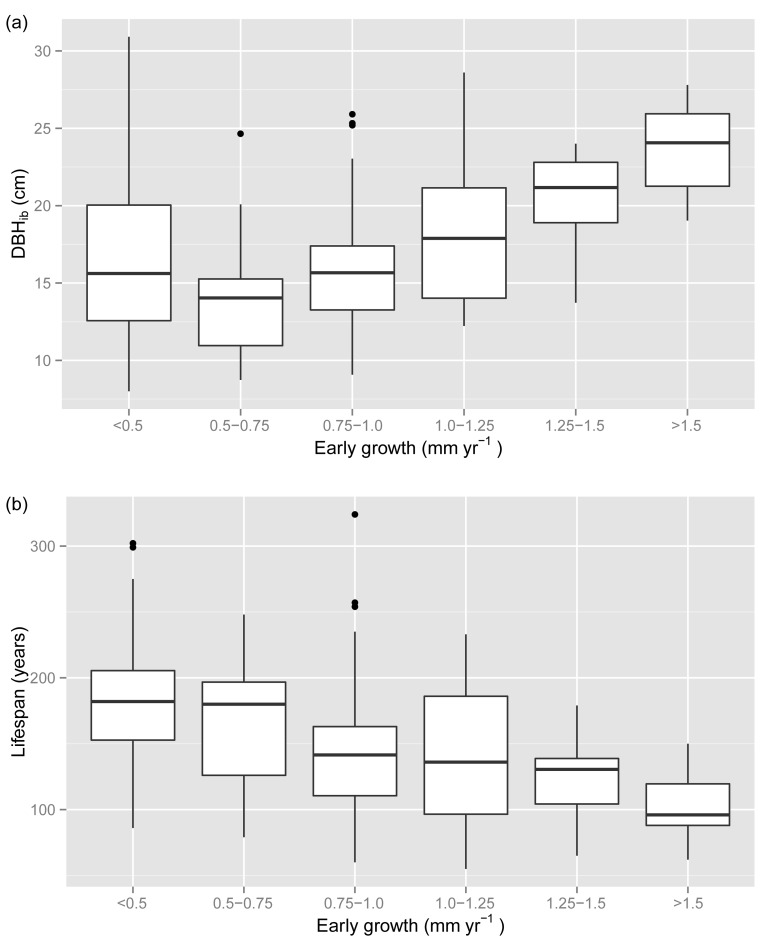
Distribution of tree size and lifespan versus early growth.Boxplots of (a) DBHib (diameter at breast height inside bark) at the time of tree death; and (b) lifespan. The variables are plotted for different classes of early growth (mean ring width over the first 50 years; n = 160 trees).